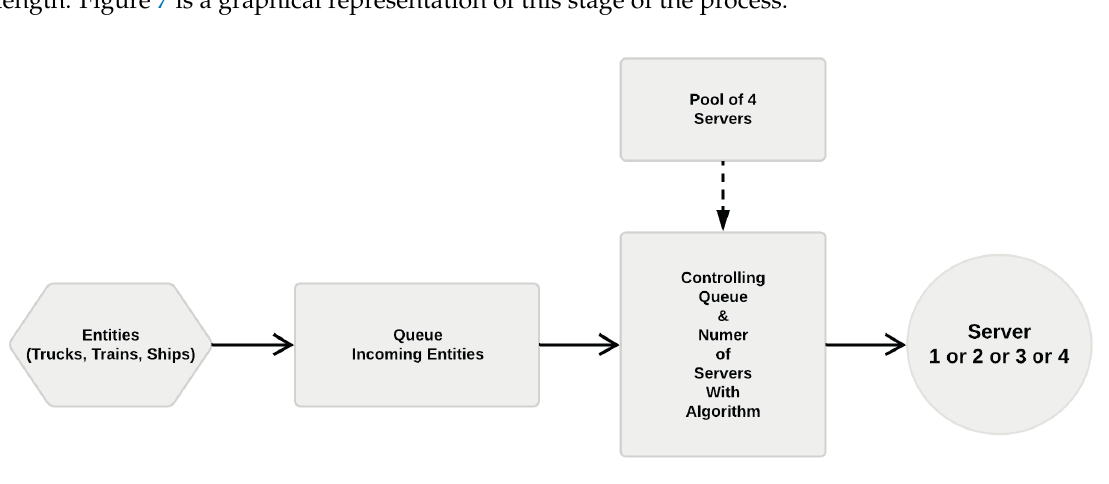
Figure 7. Block scheme of controlling queue length of incoming entities and number of working